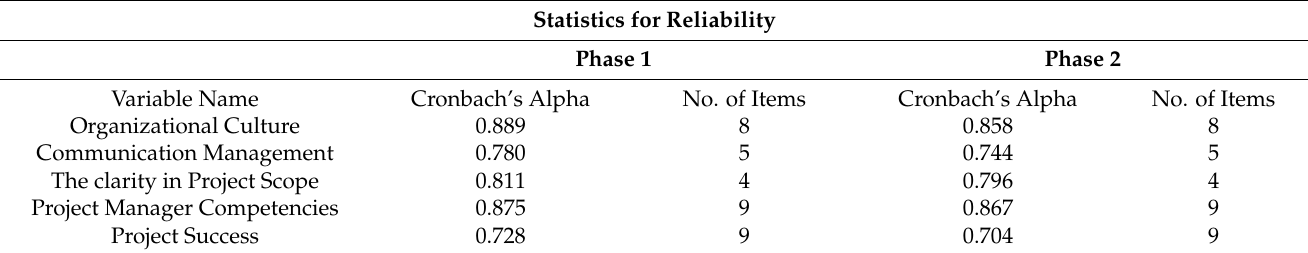
Table 5. Test for reliability phase 1 (individual